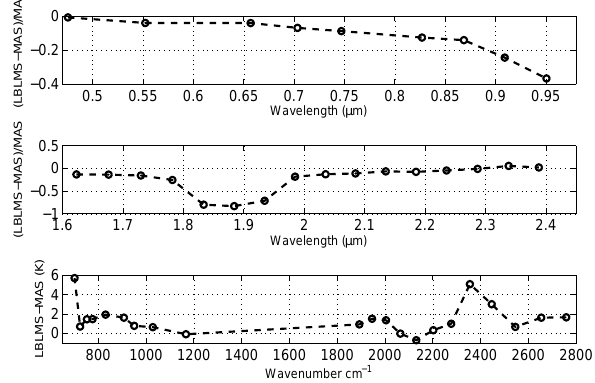
Fig. 5. Differences between LBLMS simulations and MAS obser- vation at nadir in clear sky conditions. Top and mid panel: rela- tive radiance errors (LBLMS-MAS)/MAS; lower panel: absolute IR brightness temperature difference (LBLMS-MAS,